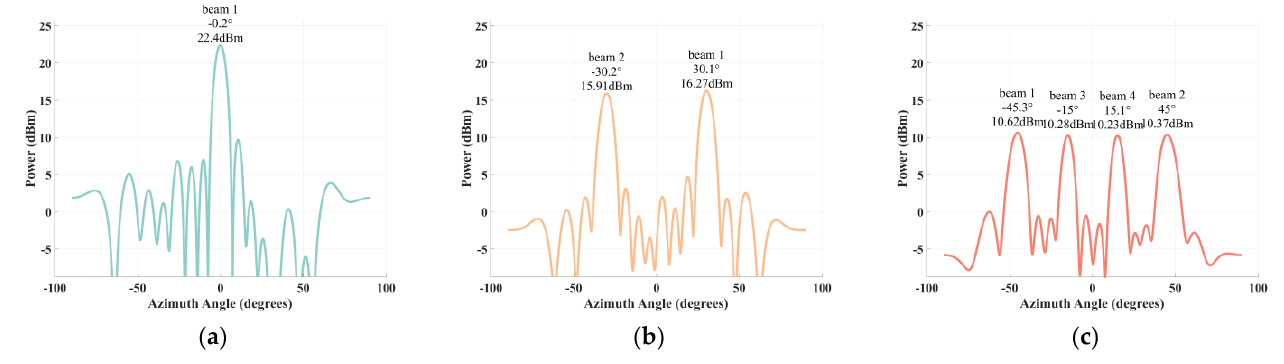
Figure 7. The multi − beam pattern in amplitude and phase inconsistency with the variances are 0.5 dB and 0.5 ps. ( a ) single − beam mode; ( b ) dual − beam mode; ( c ) four − beam mode.